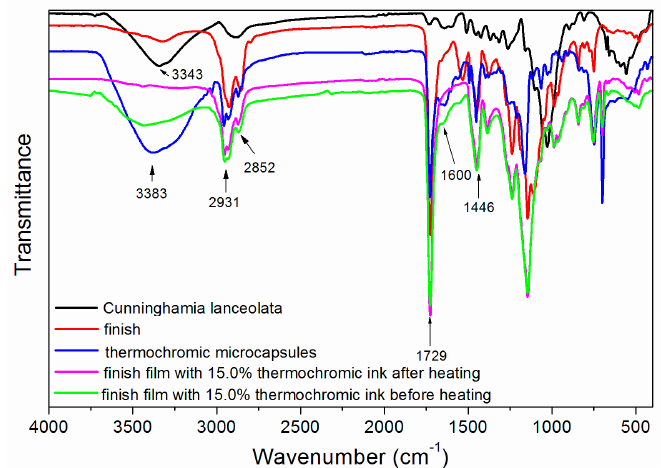
Figure 8. Infrared spectra of Cunninghamia lanceolata, waterborne wood finish, thermochromic microcapsules, finish film with 15.0% thermochromic ink before and after heating. Table 9. Assignment of the bands.